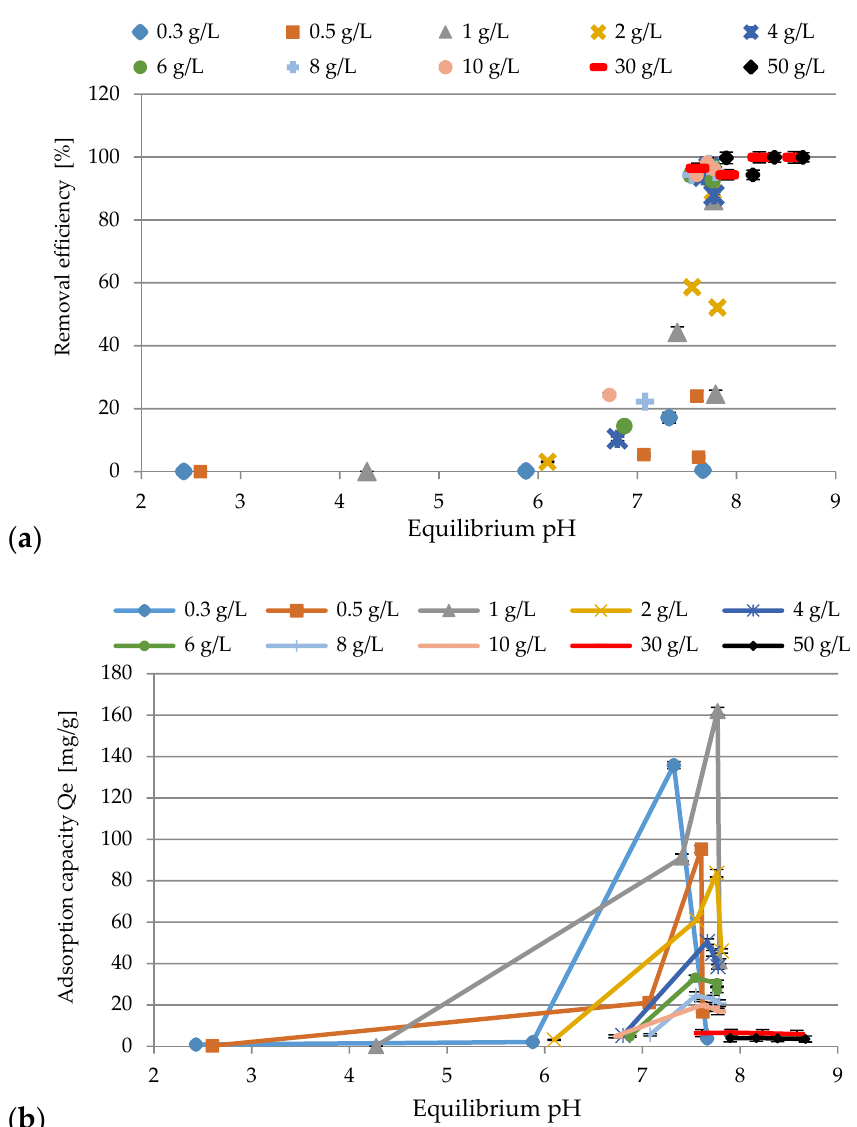
Figure 7. The relationship between equilibrium pH and removal efficiency ( a ) and adsorption capacity ( b ) of Ni(II) ions with SS-FA.